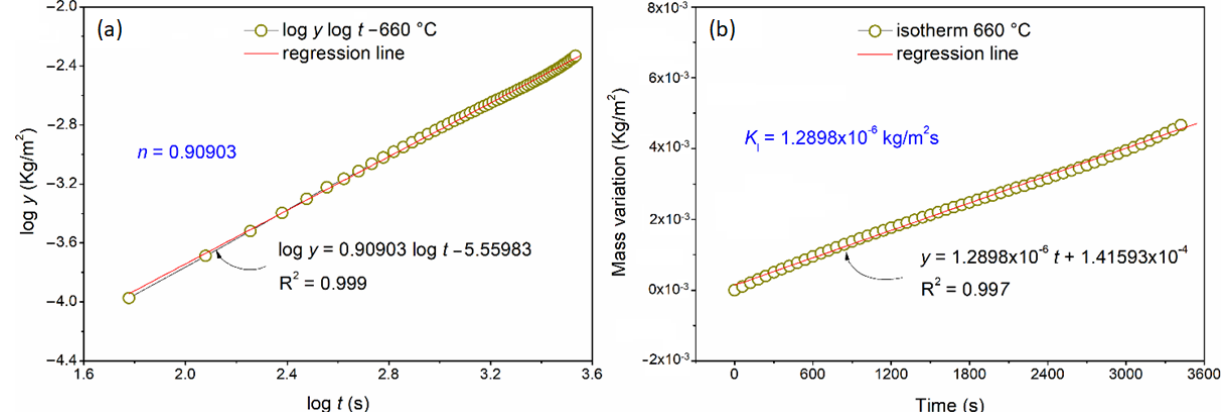
Figure 6. Mass variation per unit surface area as a function of the exposure time for the Ni-based alloy at 660 ◦ C: ( a ) log y versus log t to determine the oxidation rate index ( n ) and ( b ) y versus t to determine the linear oxidation rate constant ( K l